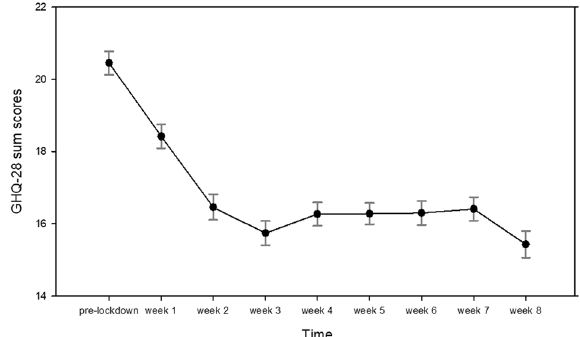
Fig. 3 Mean scores and standard errors of mental dysfunctions (GHQ-28) prior to the lockdown and during weeks 1 – 8. The proposed threshold for signi fi cant distress is a total sum score of 23/ 24